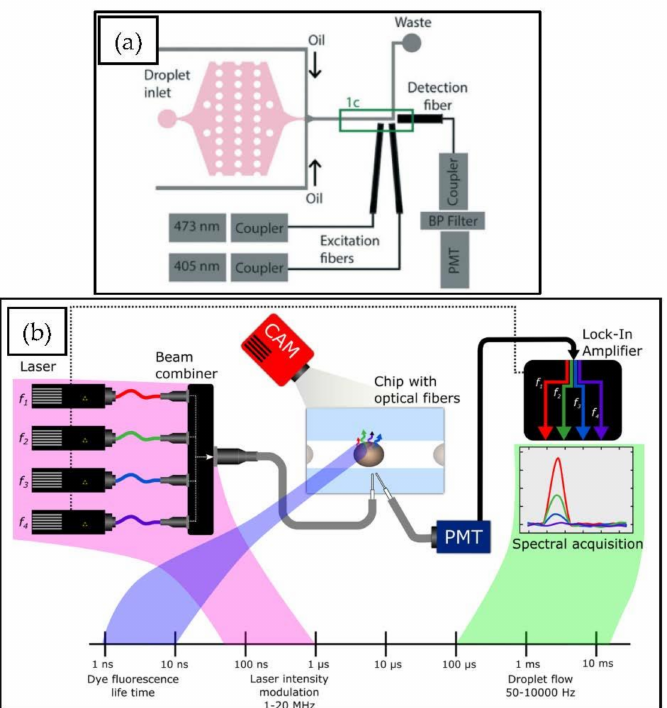
Figure 7. Detection setups used in droplet microflow cytometry (DMFC) using photomultiplier tubes (PMT) as a detector. ( a ) Measurement system where multiple lasers are used and coupled into the microfluidic chip. Knowing the flow speed, multiple analyses of droplets can be done using only one PMT tube [84]; ( b ) a measurement setup consisting of one PMT capable of measuring four parameters at the same time, using lasers for light sources, beam combiner, and lock-in amplifier to demodulate the result [83]. Reproduced from with permission from